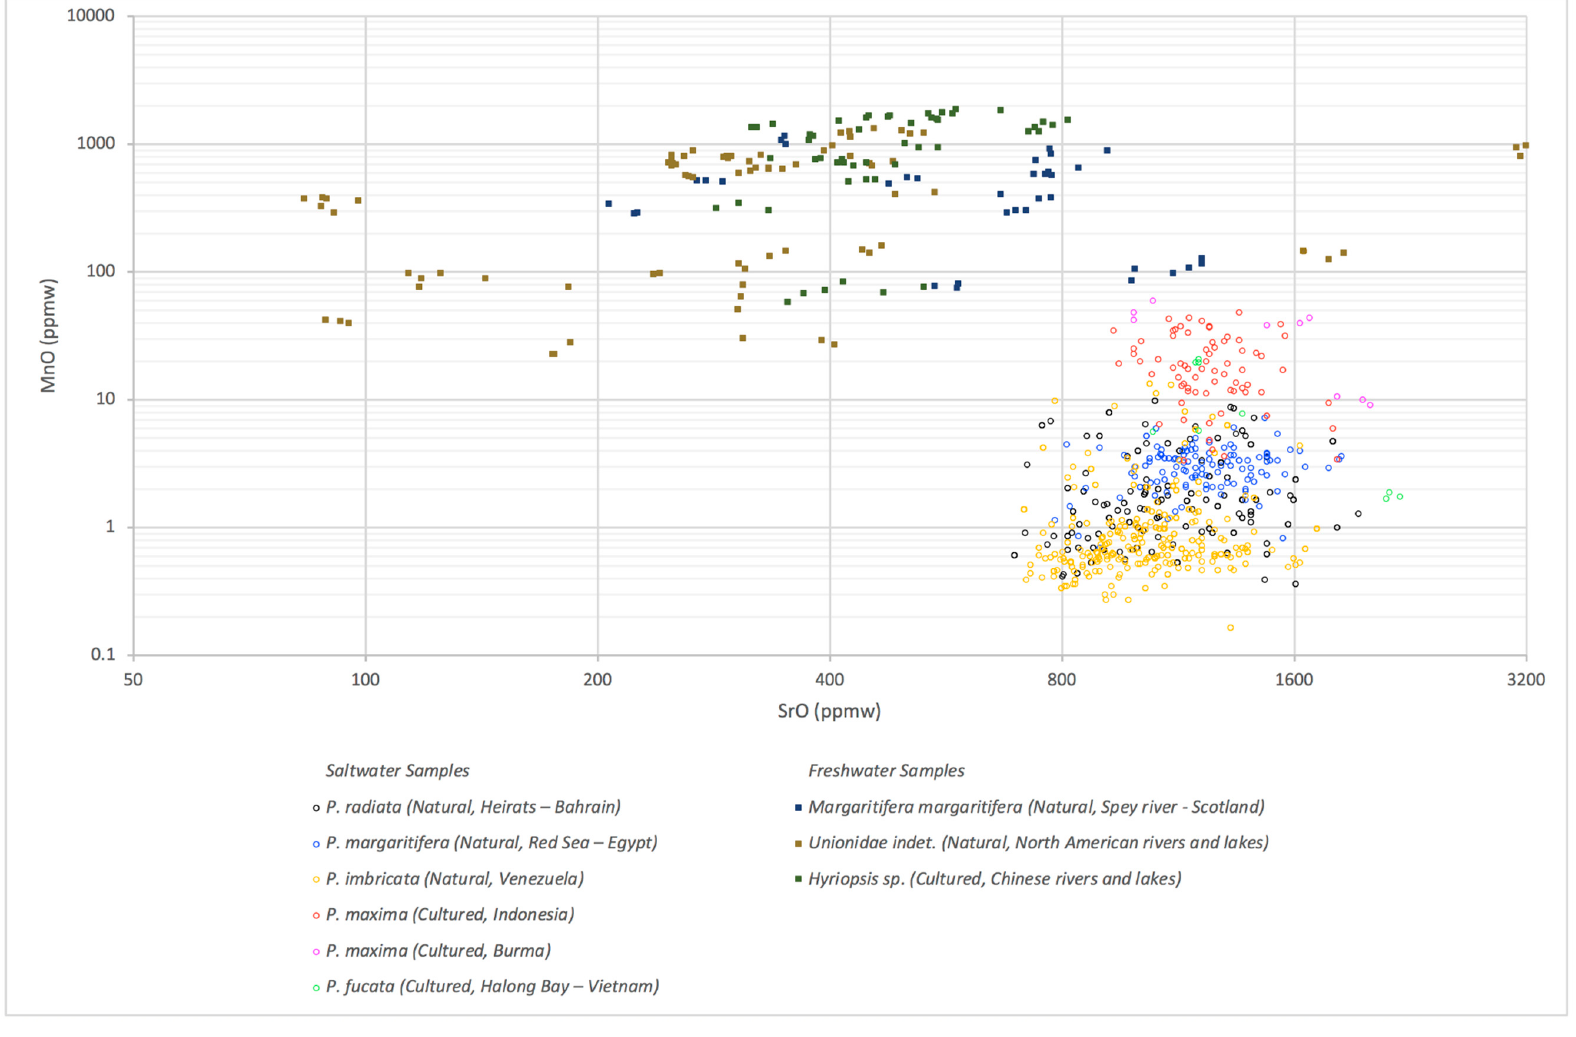
Figure 1. Binary plot of SrO vs. MnO.